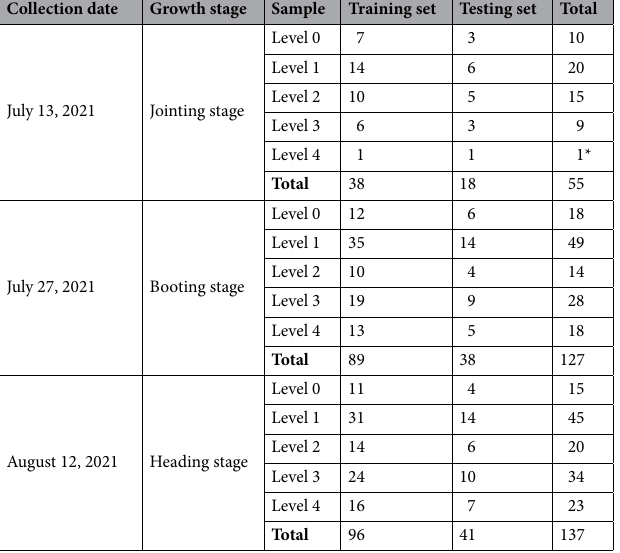
Table 5. Description of samples used in this study. *The sole level-4 sample was assigned to both sets